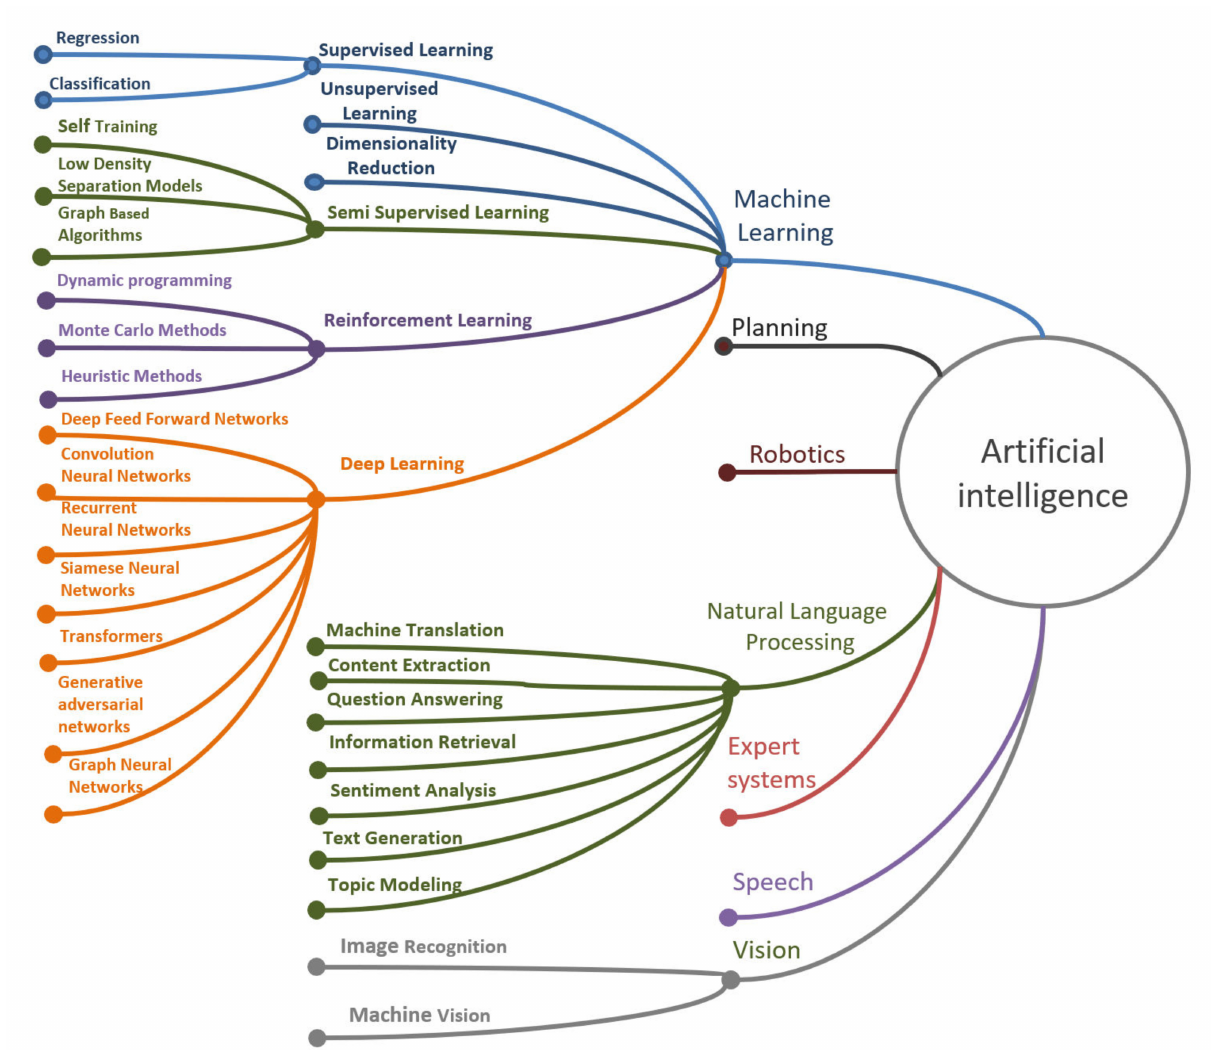
Figure 3. Subsections of artificial intelligence. Source: generated by the